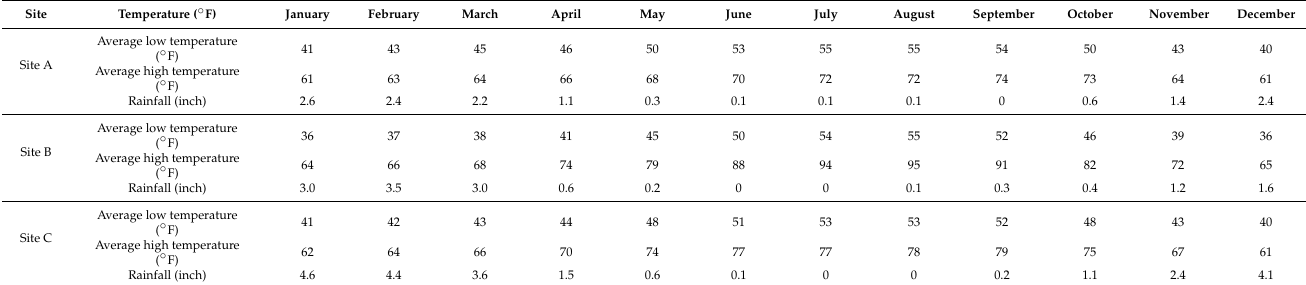
Table 2. Meteorological data for three sites’ average, from 2016 to 2020 1